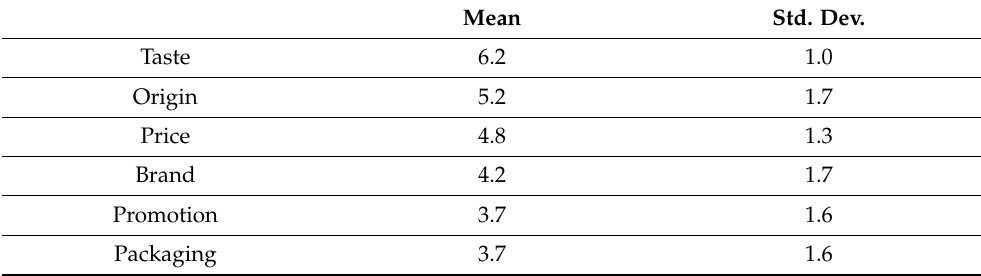
Table 4. Products’ attributes that affect consumer purchasing behaviour of processed tomato products. Mean Std. Dev.